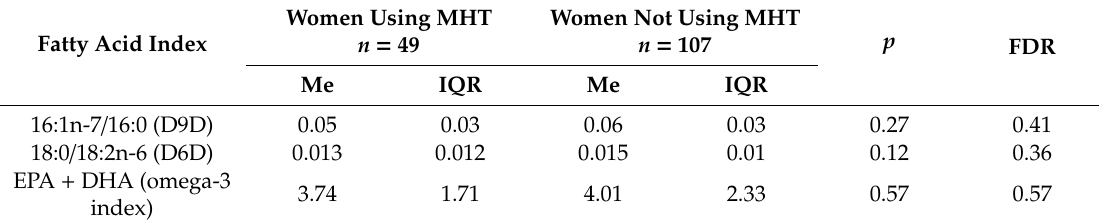
Table 5. Correlation between desaturase and omega-3 indices and the duration of MHT